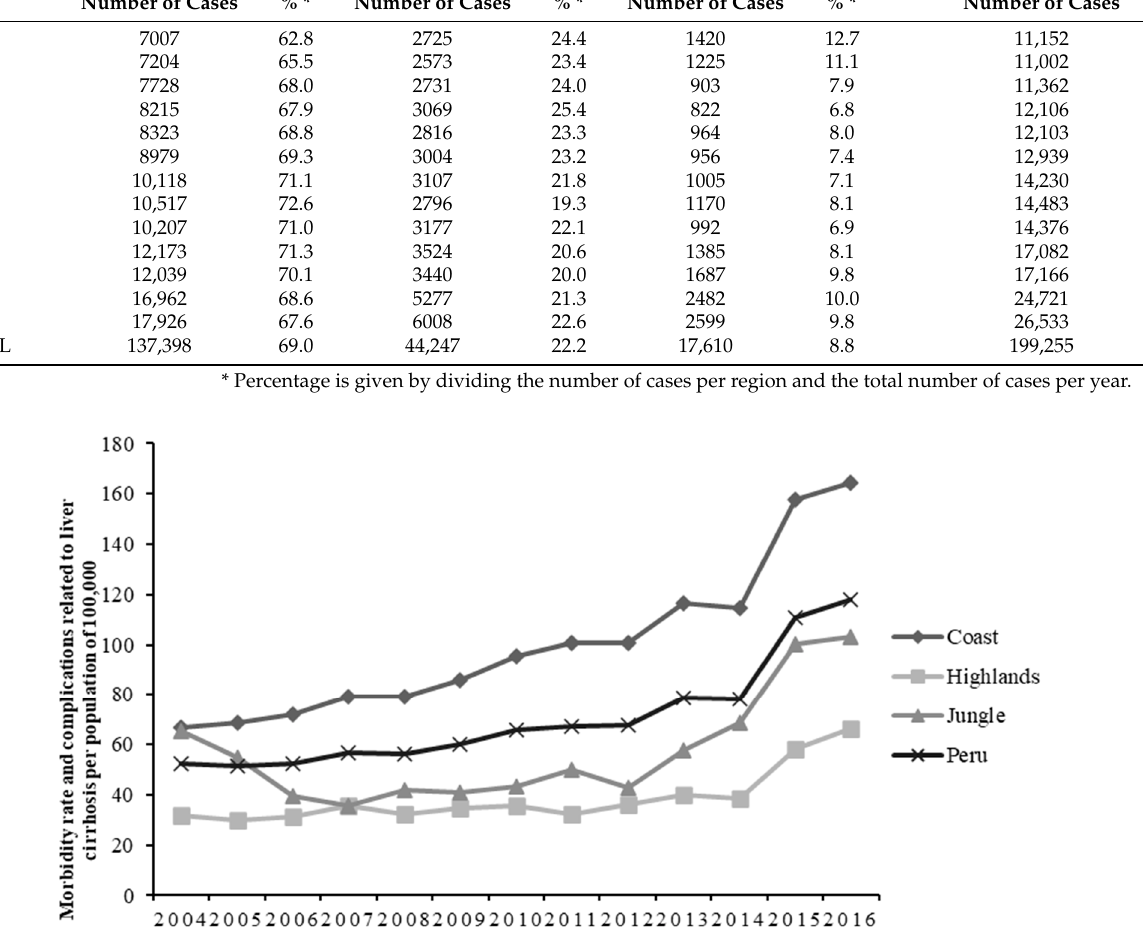
Table 1. Morbidity and complications related to liver cirrhosis according to region and year of death for the period 2004-2016.